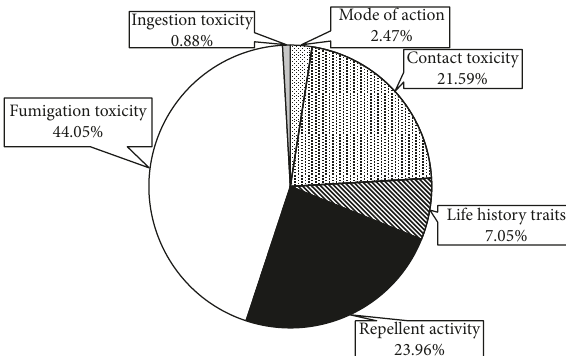
Figure 3: Percentage of different research topics accounted in the analysed